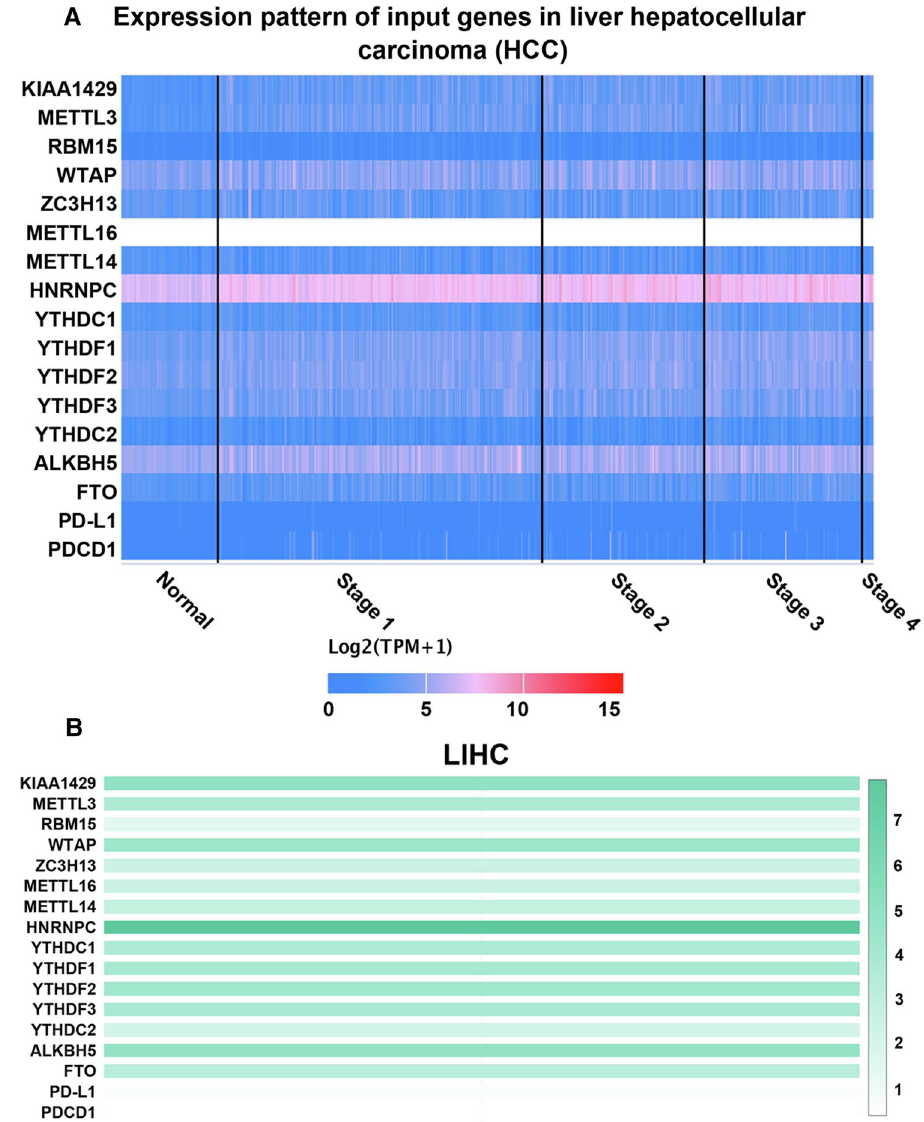
Fig. 2 A Differential heat maps of expression of m6A regulators and PD-L1 in HCC tumor tissues (tumor stage) and para-cancerous tissues. B Relative levels of m6A regula- tors and PD-L1 in HCC. The expression of HNRNPC was the highest in